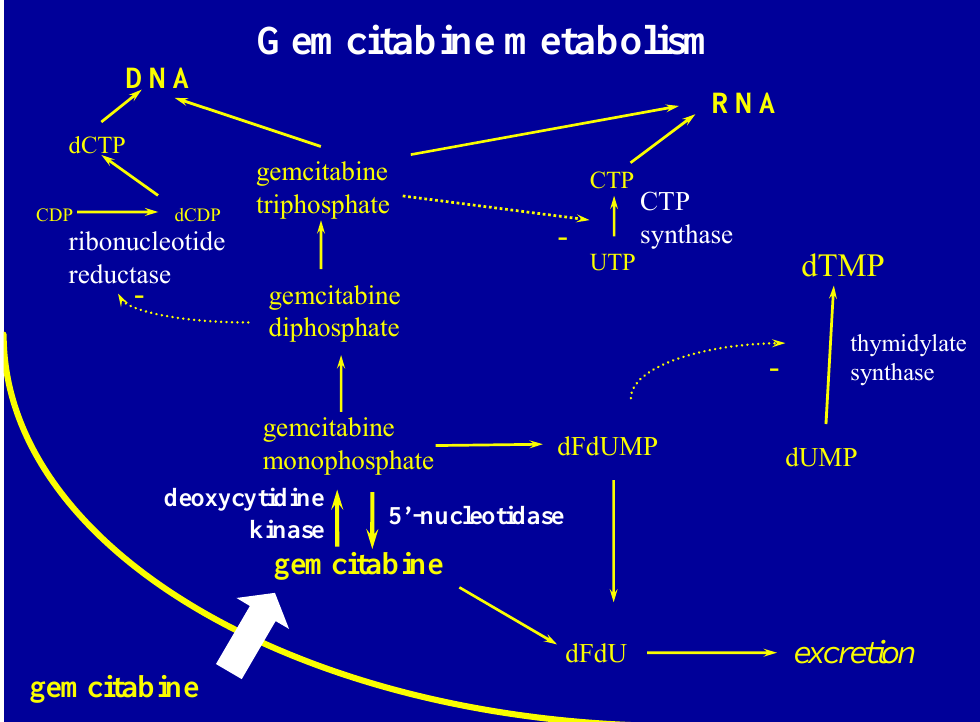
Figure 2. Gemcitabine metabolism. Abbreviations: DNA, deoxyribonucleic acid ; CDP, cytidine diphosphate; dCDP, deoxycytidine